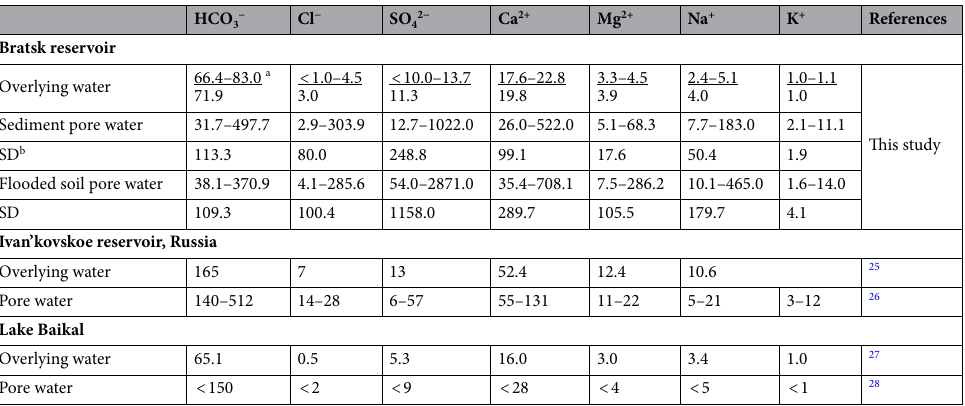
Table 2. Comparison of major ion concentrations (mg L −1 ) in overlying and pore waters of the Bratsk reservoir and other reservoirs. a Minimum–maximum value in the numerator, mean value in the denominator; b standard